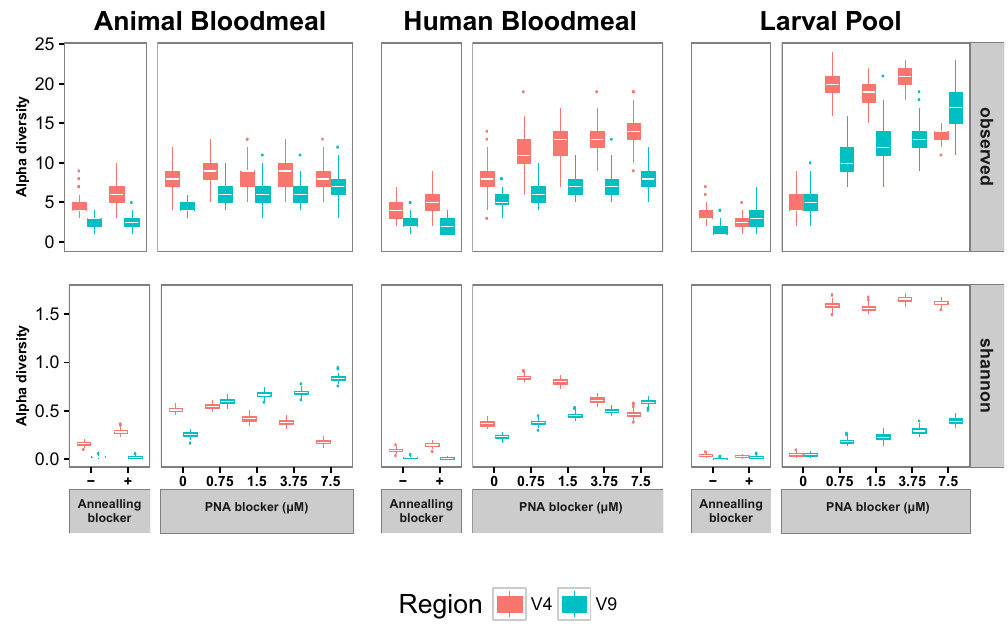
Figure 7. Influence of 18s rRNA gene blocking strategies for taxonomic richness and evenness. Alpha-diversity boxplots for the three samples of the analysis panel under different amplification conditions in the V4 (orange) and V9 (blue) hypervariable regions. Each boxplot represents 100 estimates of alpha-diversity (richness: observed species, top plot; and evenness: Shannon index, bottom plot) computed from 100 random subsamples of size 1000 in each amplicon dataset. Whiskers represent values within 1.5x of the inter-quartile range, from the third (upper whisker) and first (lower whisker) quartiles of the alpha-diversity distribution. Outlier values beyond the end of the whiskers are plotted as points.